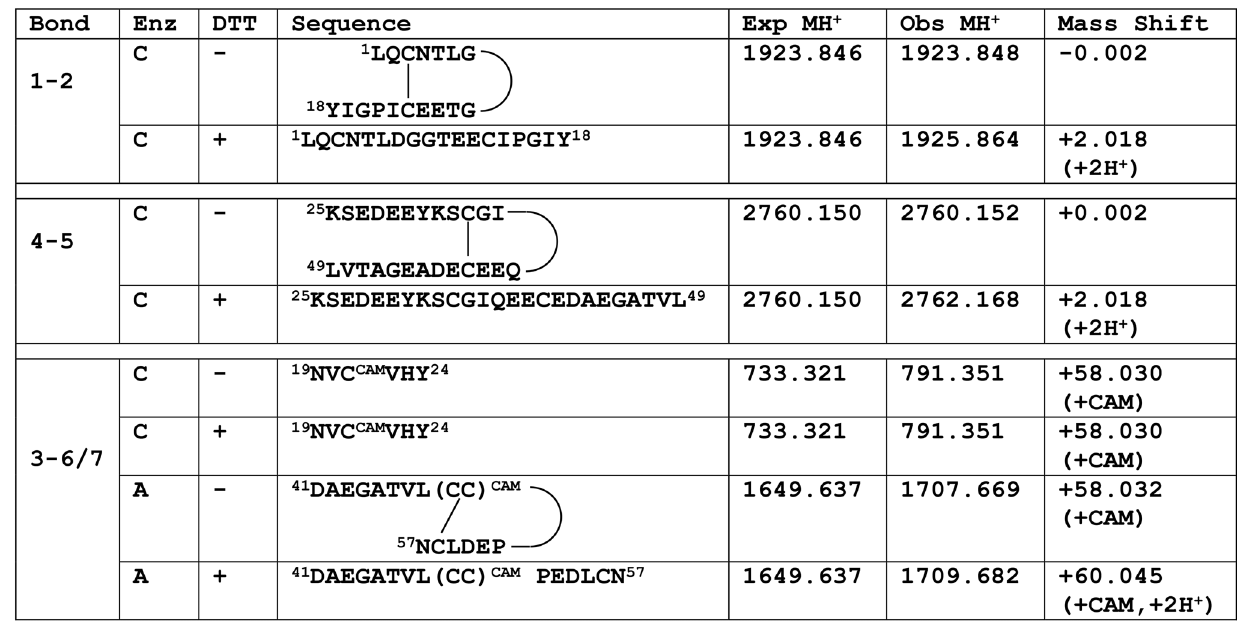
Figure 1. Summary of mass spectral analysis in PMF-G disulfide bonding pattern determination. Mass spectral analyses was performed on the three-disulfide species of PMF-G purified by RP-HPLC. Differential treatment included proteolytic enzyme (Enz; chymotrypsin [C] or AspN [A]), reduction with dithiothreitol (DTT), and alkylation with iodoacetamide (addition of a carboxyamidomethyl (CAM) group). Observed monoisotopic masses were compared to theoretical masses with no free sulfhydryls, and mass shifts used to determine peptide modification. All assignments were confirmed by analysis of the fragmented ion series.